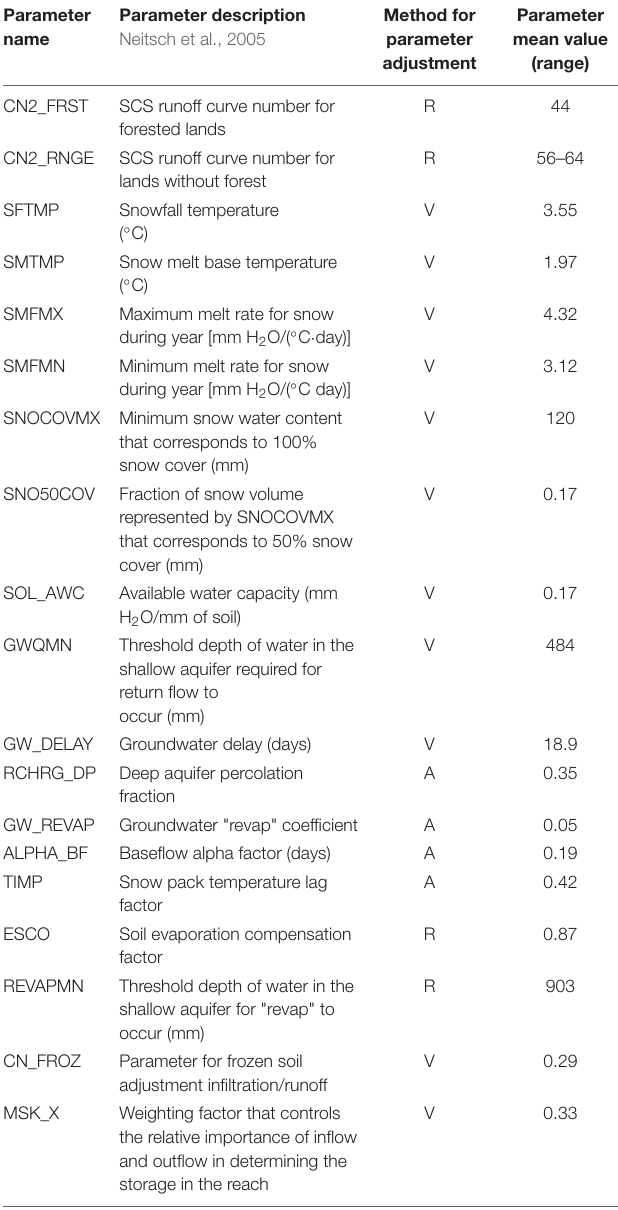
TABLE 5 | Parameters calibration results for the model.